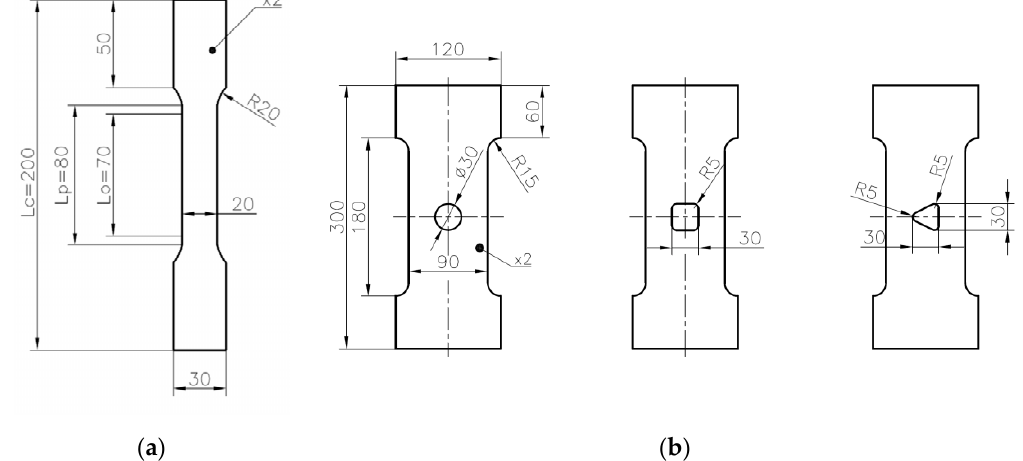
Figure 1. Dimension of samples made of S235JR + N steel: ( a ) Samples 1–3; and ( b ) Samples 4–6.